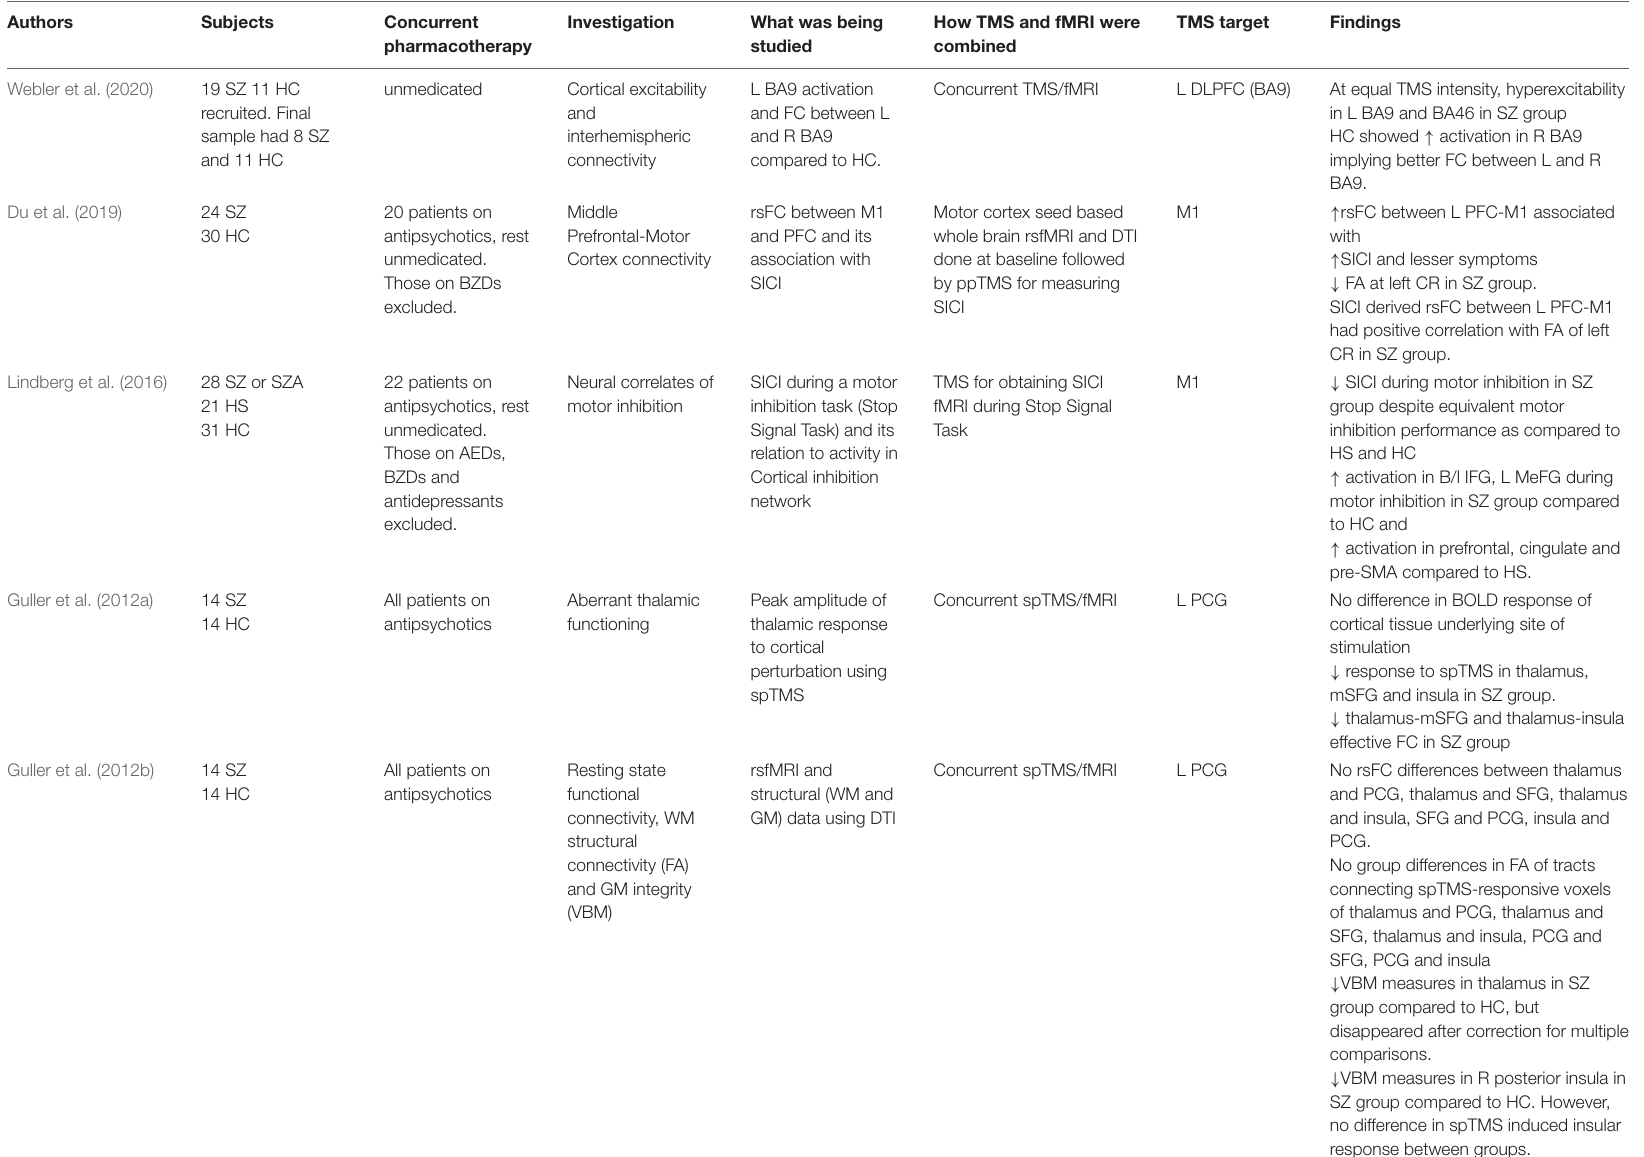
TABLE 1 | Technical aspects and principal findings of TMS/fMRI studies exploring pathophysiology of